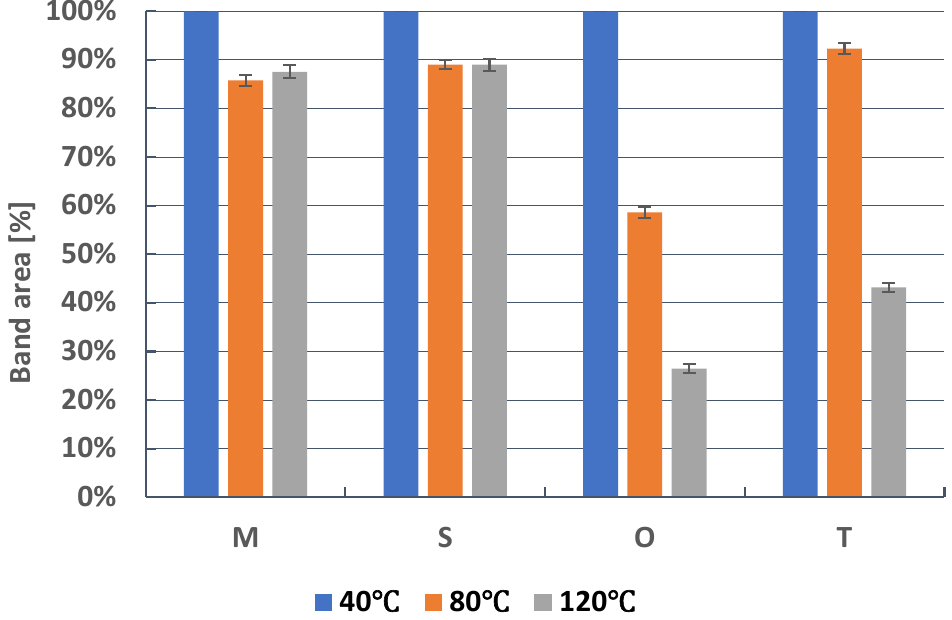
Figure 2. The comparison of means area ( ± SD) (%) of chromatographic bands obtained of metronidazole (M), secnidazole (S), ornidazole (O), and tinidazole (T) which were heated on silica gel at 40 ◦ C, 80 ◦ C, and 120 ◦ C for 24 h and developed in the chloroform–methanol (9:1, v / v ) as the mobile phase, where SD is the standard deviation.